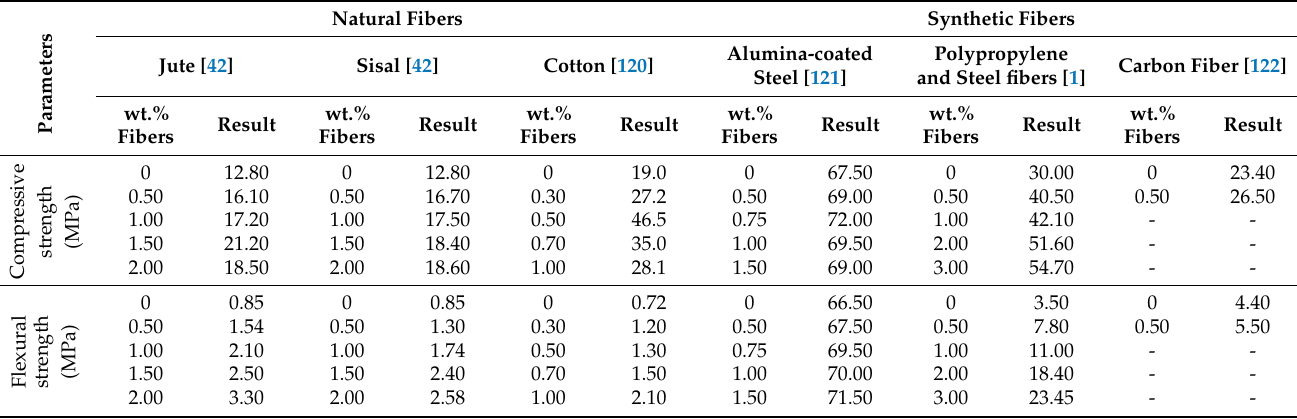
Table 2. Comparative results of some researches with geopolymers reinforced with natural and synthetic